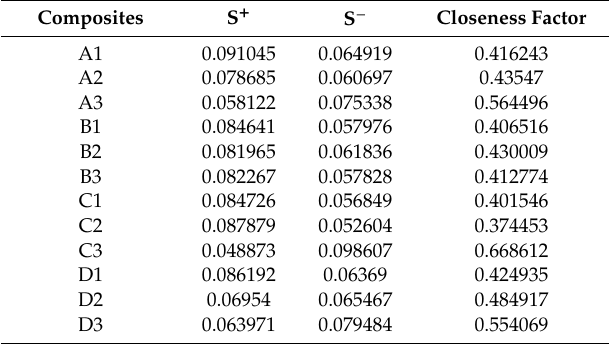
Table 8. Separation measure, relative closeness, and